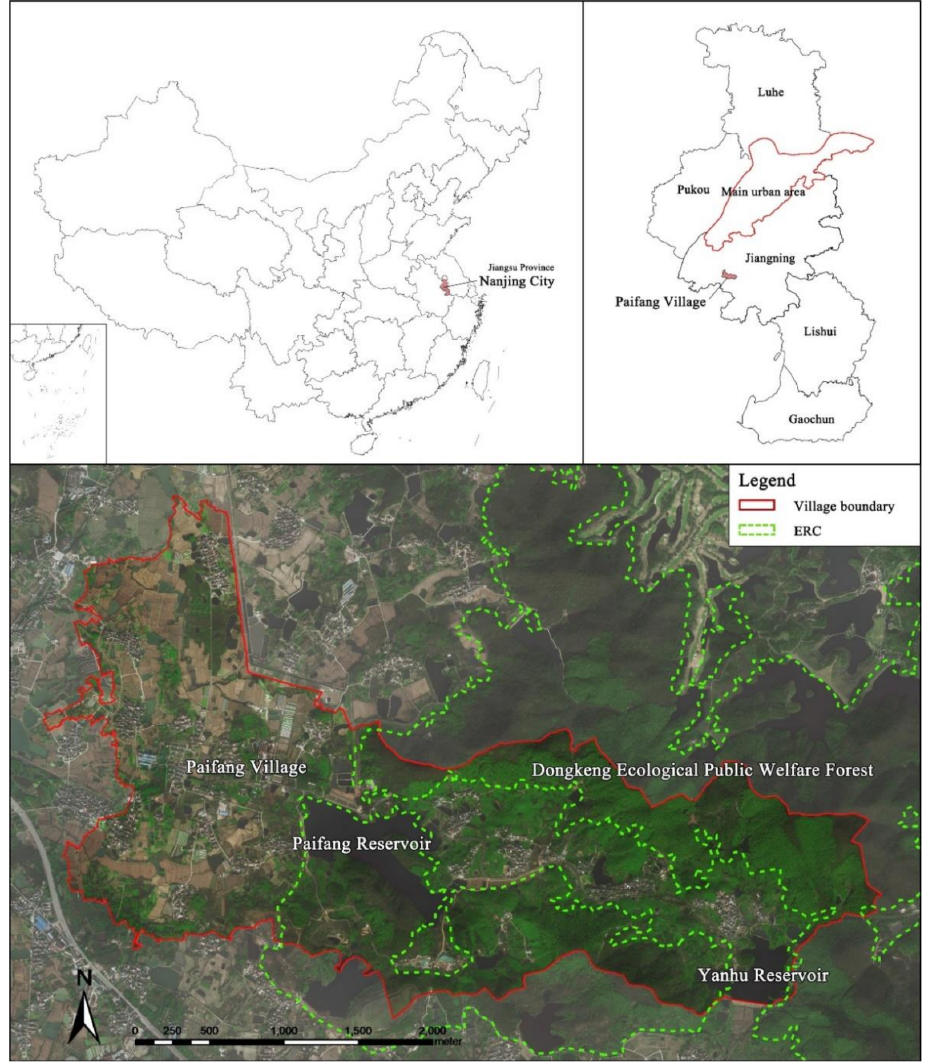
Figure 2. The geographical location of study